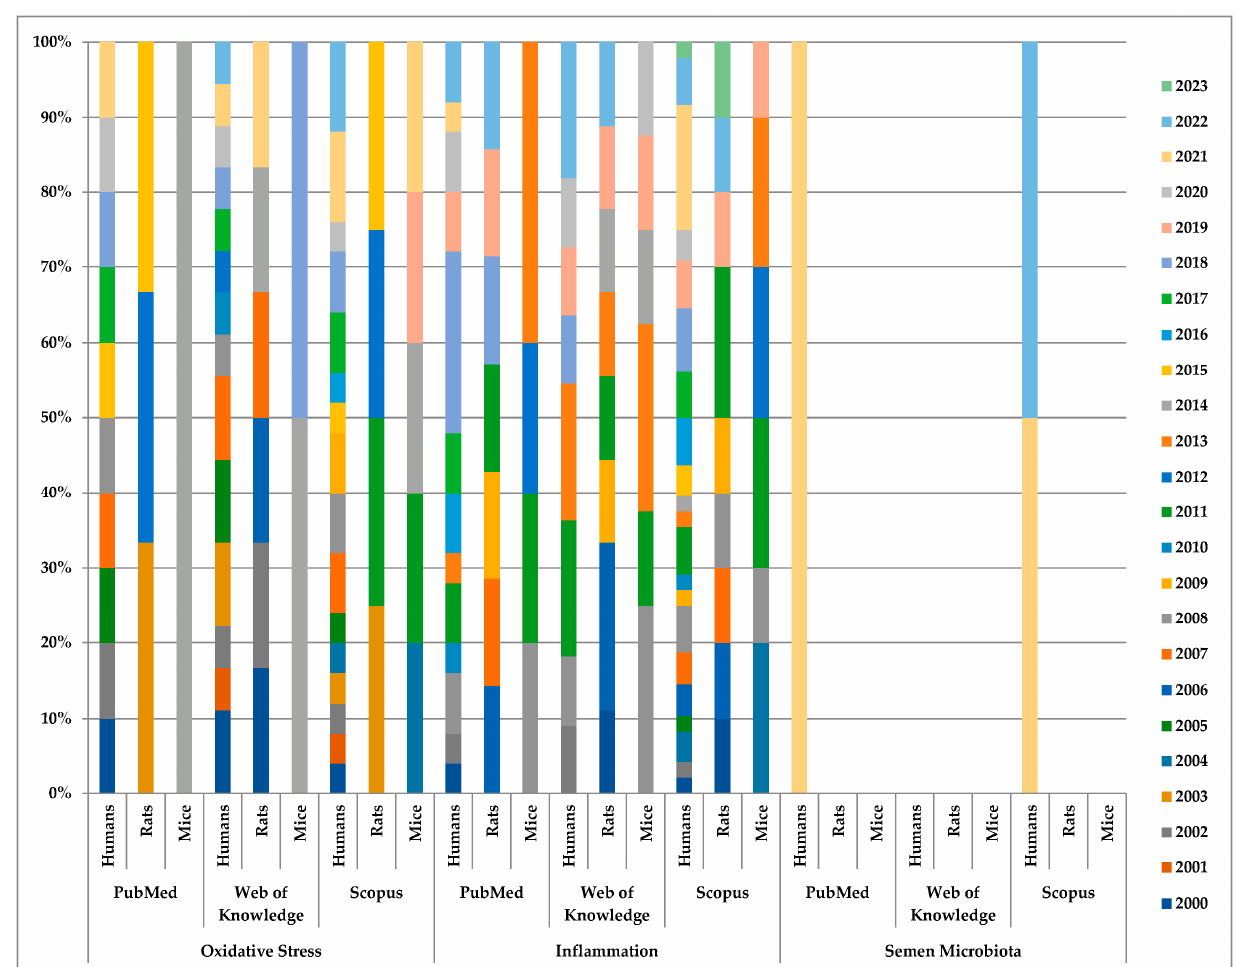
Figure 1. Diagram presenting the study percentage per year of publication based on the academic database, keywords, and model category.